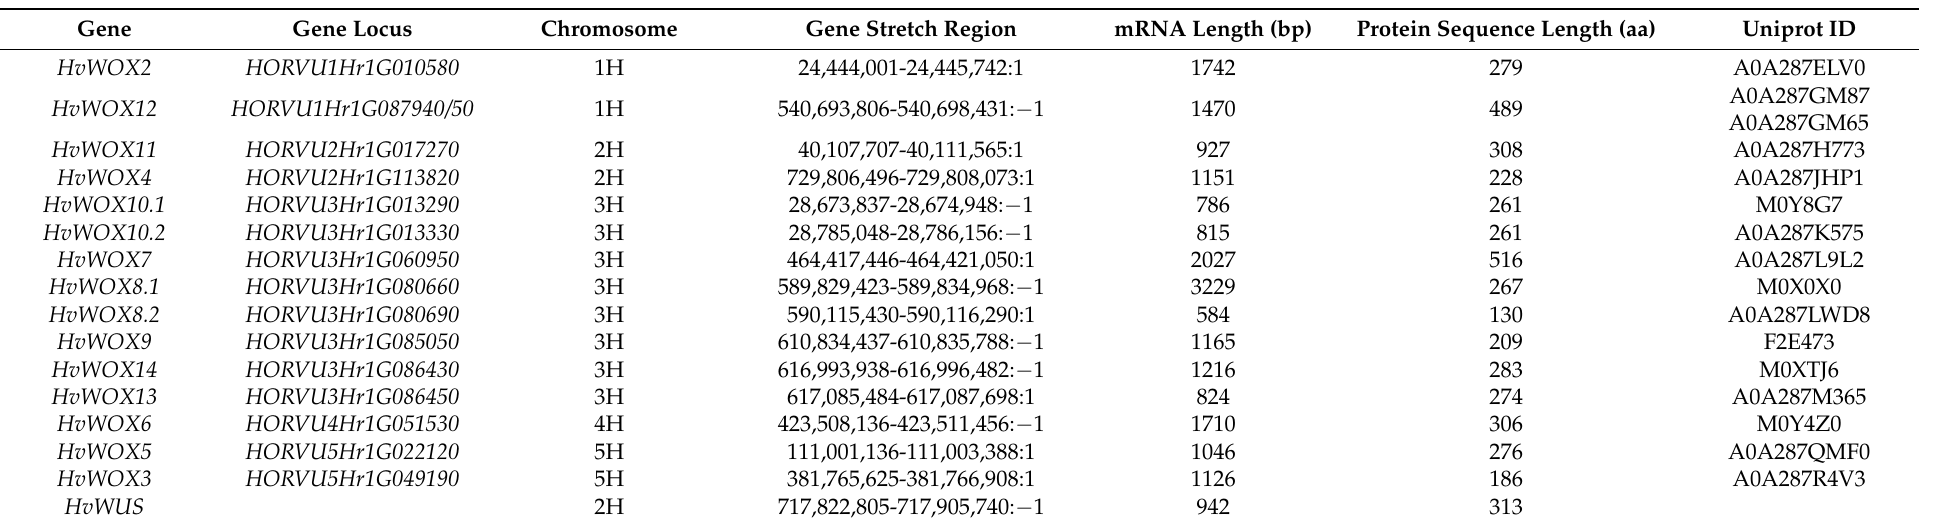
Table 2. Characteristics of HvWOX gene family members in H. vulgare